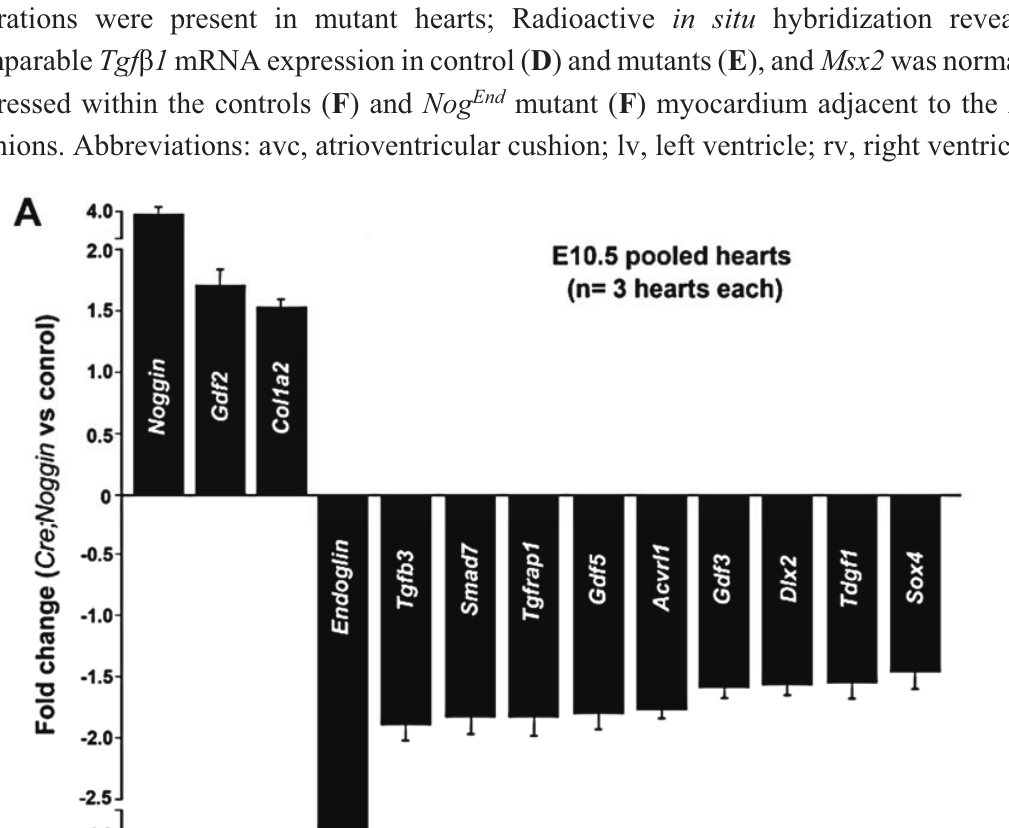
Figure 5. qPCR mRNA profiling and in situ verification of expression